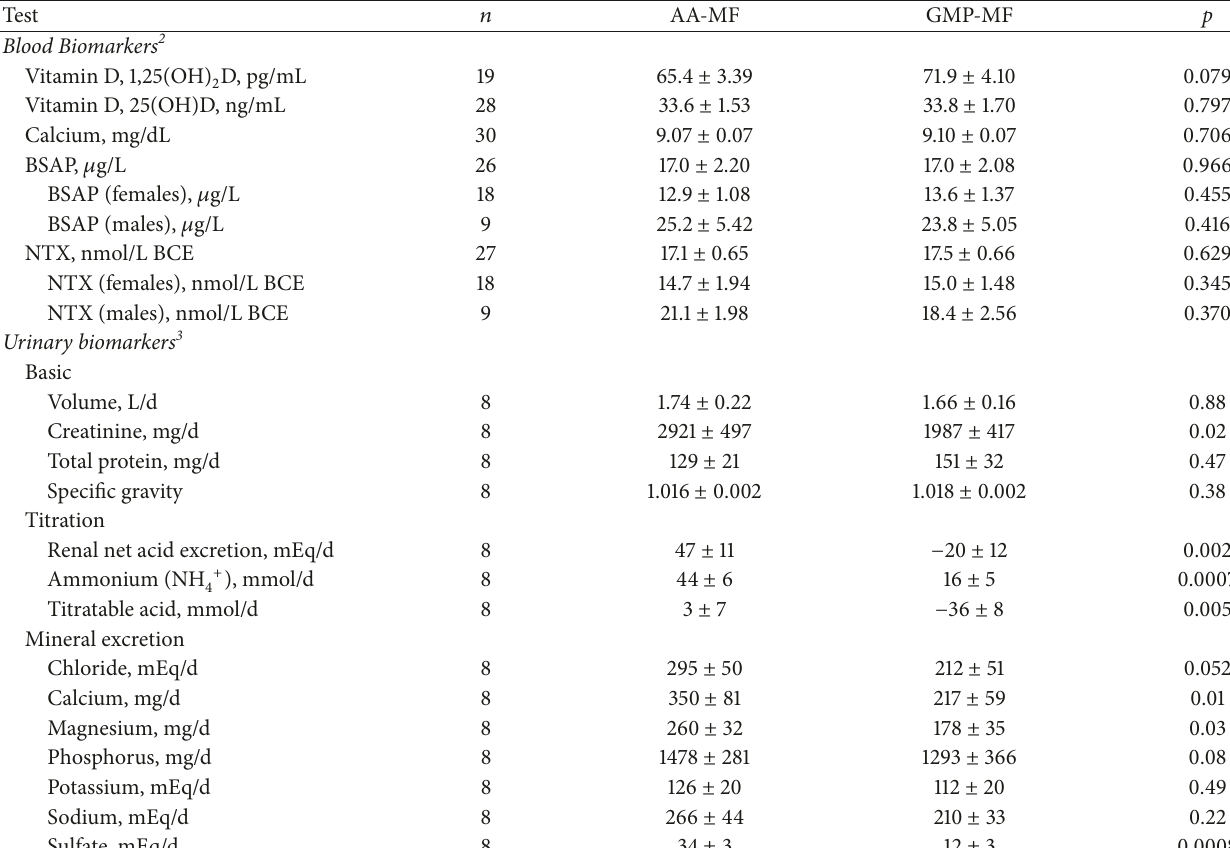
Table 3: Bone-related blood and urine biomarkers with AA-MF or GMP-MF 1